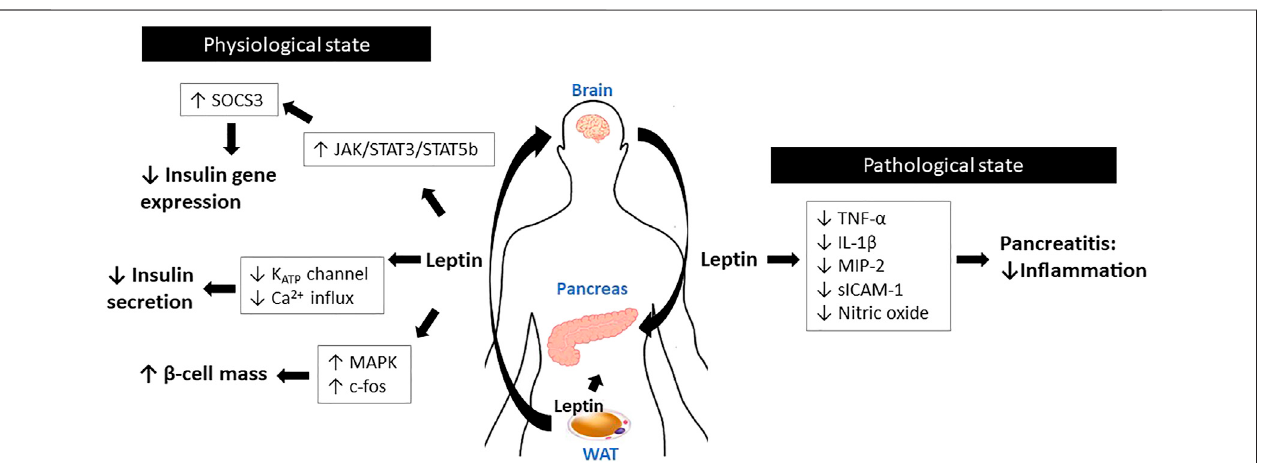
FIGURE 4 | Schematic diagram for the roles of leptin in the pancreas.